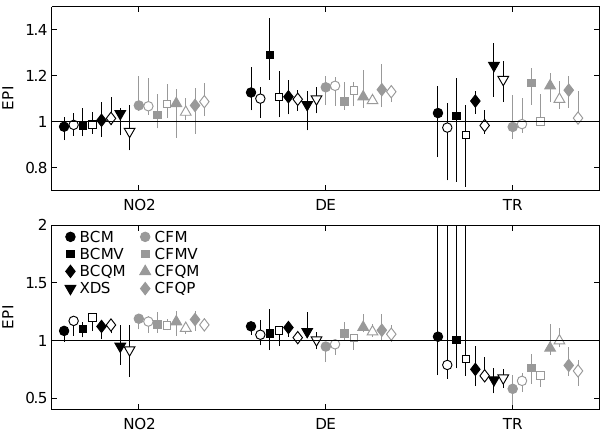
Figure 5. EPI for each SDM for NO2, DE, and TR for winter (top) and summer (bottom). The markers indicate the median and the lines represent the range covered by the 25th and 75th percentiles. The results are shown for 1-day (filled markers) and 30-day (hollow markers) temporal aggregation. The same symbols are used for the different downscaling methods as in Fig. 4. Note the different scales used in the y axis for winter and for